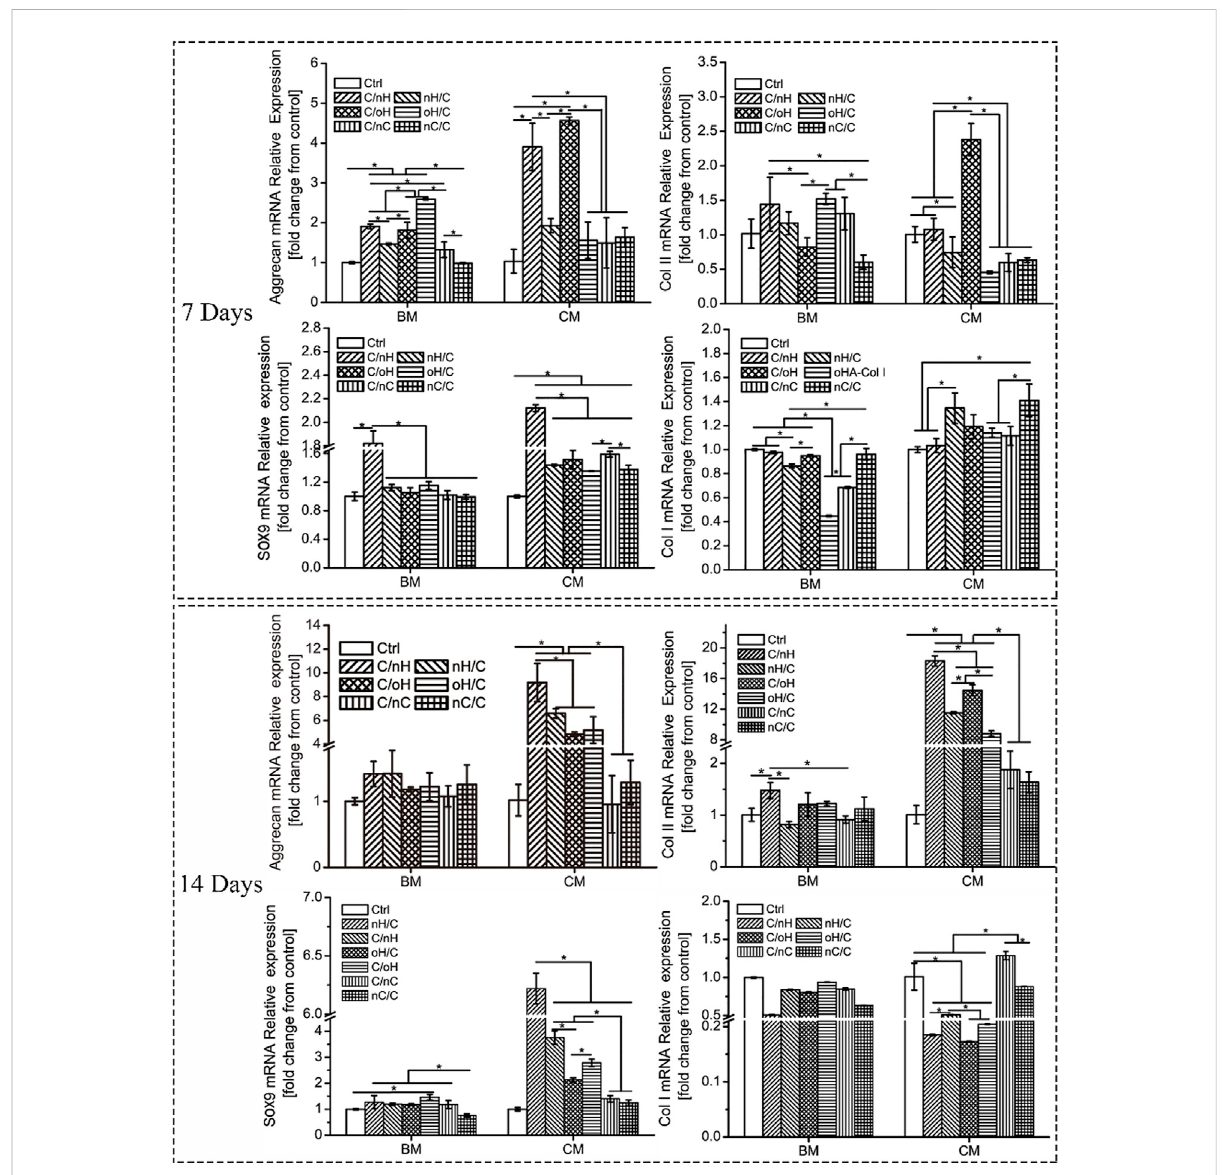
FIGURE 4 Relativeexpressionlevelsofchondrogenic-associatedgenesinhUC-MSCsgrownondifferentPEMatdifferenttimepoints.[BM:basalmedium; CM: chondrogenic differentiation medium]. The multilayers are the same as described in Figure